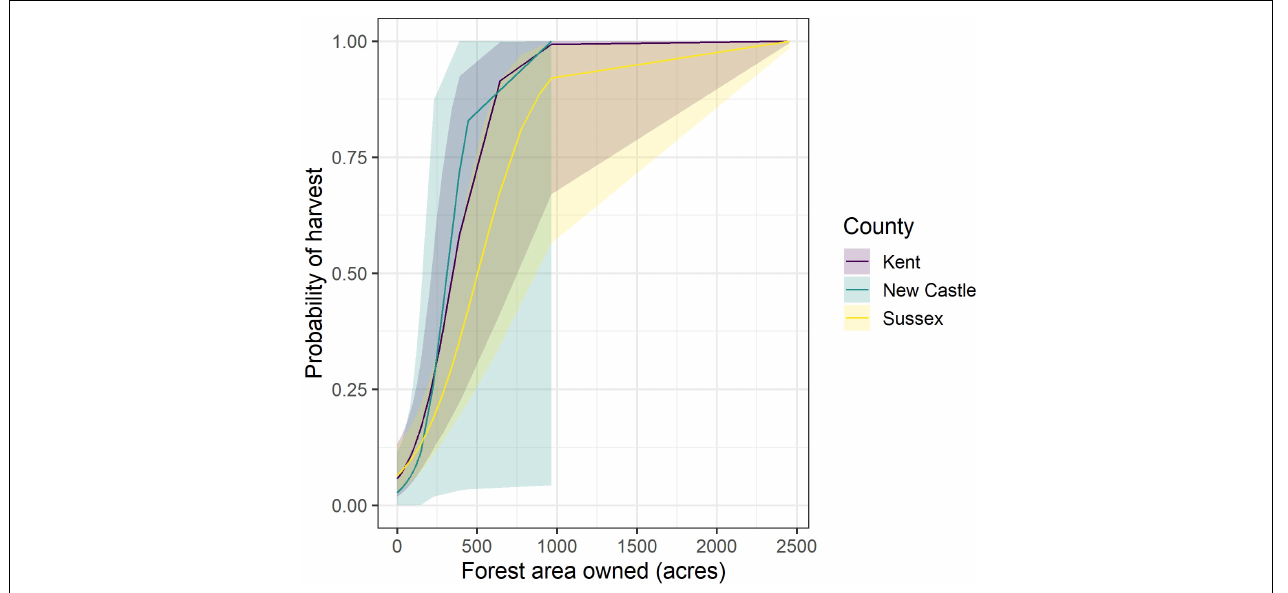
FIGURE 3 | Predicted probability of commercial forest harvest (previous 5 years) by family forest ownerships, by county and size-of-forest-holdings in Delaware, United States. Lines represent posterior median and bands show 95% credible intervals.